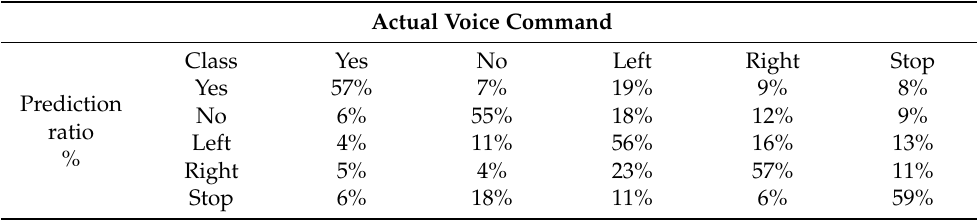
Table 5. Normalized confusion